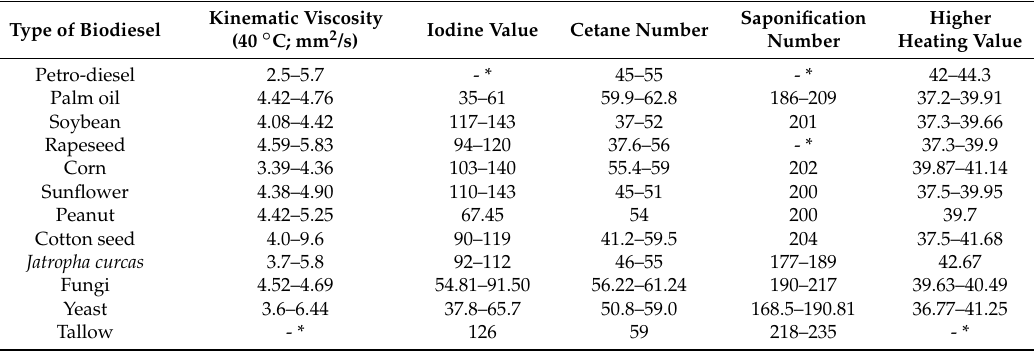
Table 9. Main fuel-related properties of biodiesel produced from various raw materials [48,84,86,94,